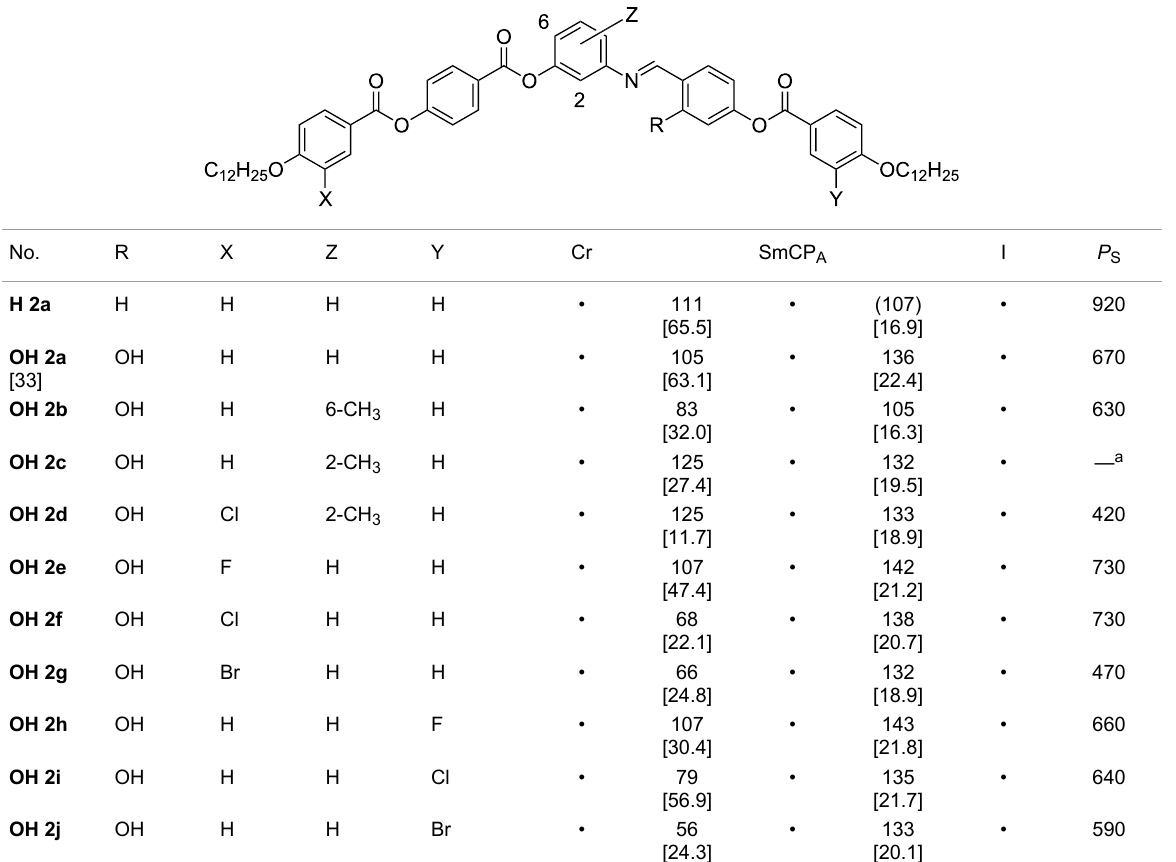
Table 2: Mesophase behaviour, transition temperatures (°C), transition enthalpies [kJ/mol] and P S [nC/cm 2 ] values of the compounds OH 2 and H 2a .